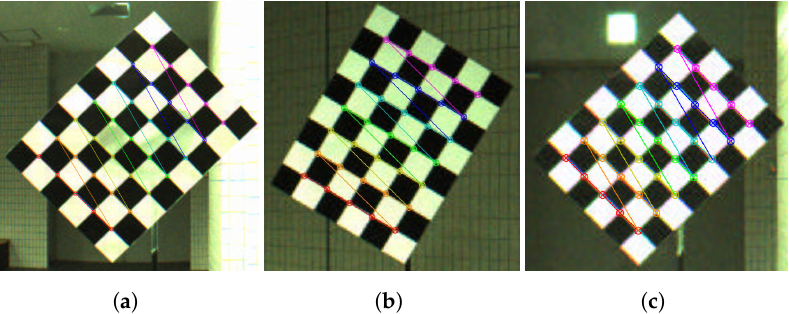
Figure 14. Detected corners from the panoramic images. ( a – c ) Example results of detected corners from images with different poses and